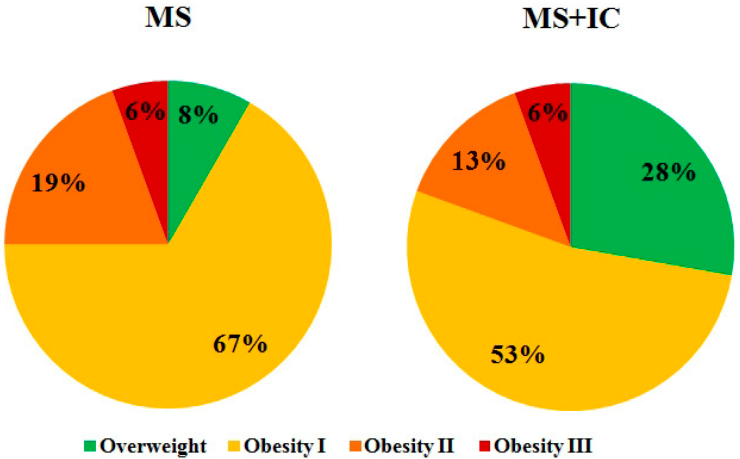
Figure 5. Distribution by severity of obesity before and after therapy. Notes: Classification of obesity by BMI: body weight deficit < 18.5 kg/m 2 ; normal body weight 18.5–24.9 kg/m 2 ; overweight 25–29.9 kg/m 2 ; obesity of the 1st degree 30–34.9 kg/m 2 ; obesity of the 2nd degree 35–39.9 kg/m 2 ; obesity of the 3rd degree ≥ 40 kg/m 2 . MS—patients with metabolic syndrome; MS+IC—patients with metabolic syndrome after consumption of indigenous consortium.